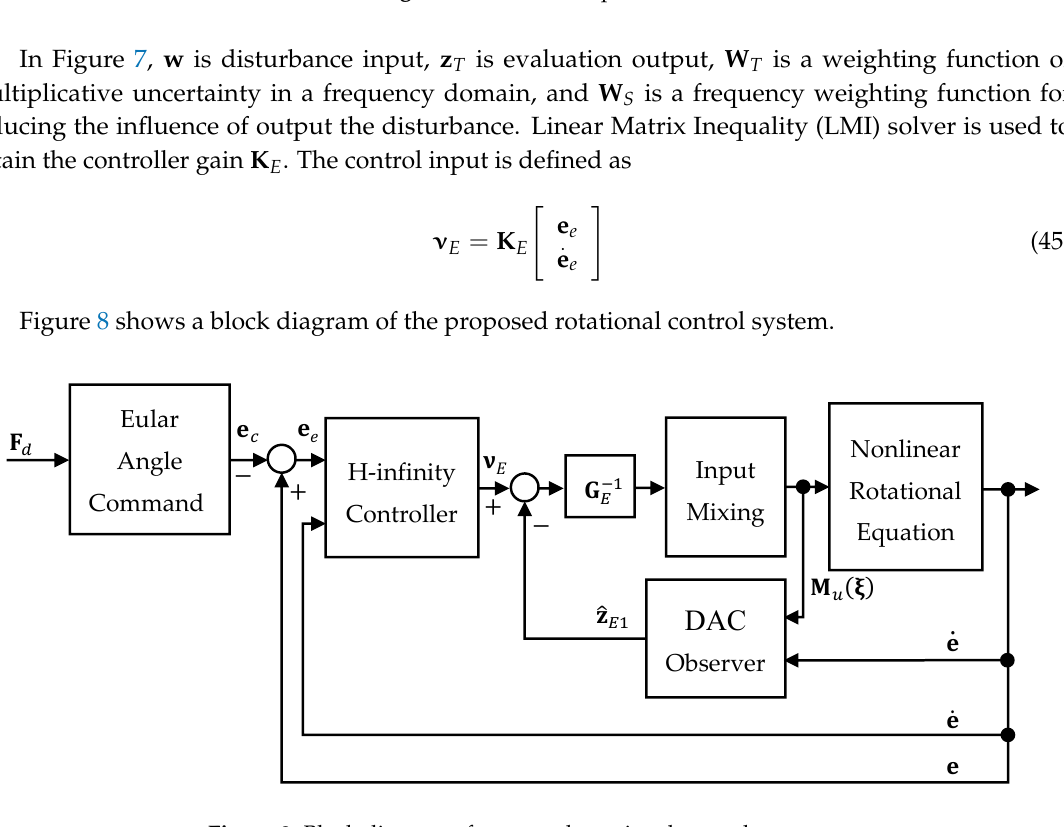
Figure 8. Block diagram of proposed rotational control system.